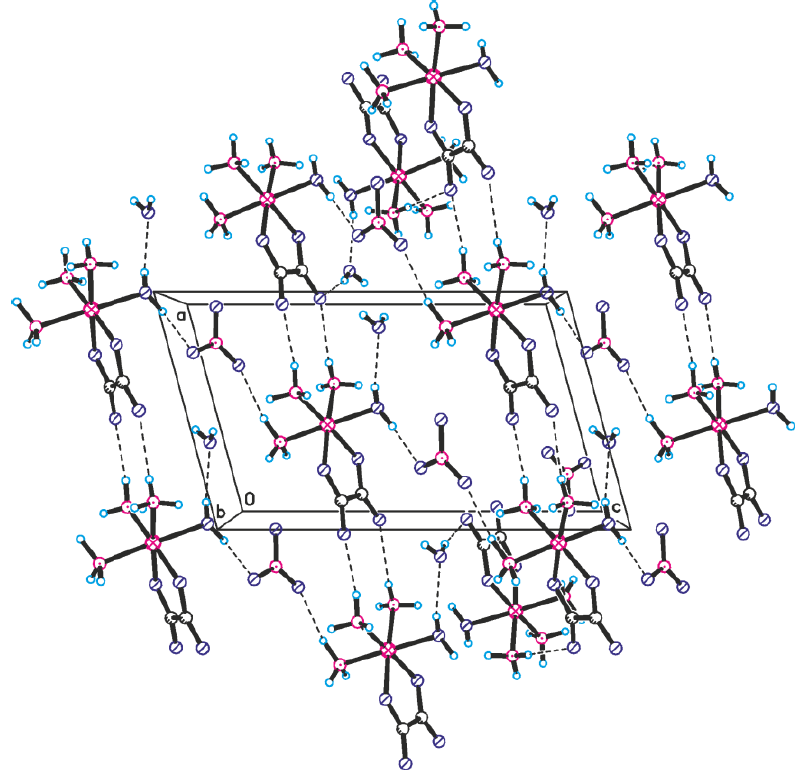
Figure 2. Crystal packing of the title compound fac -[Co(NH 3 ) 3 (C 2 O 4 )(H 2 O)]NO 3 ·H 2 O ( 2